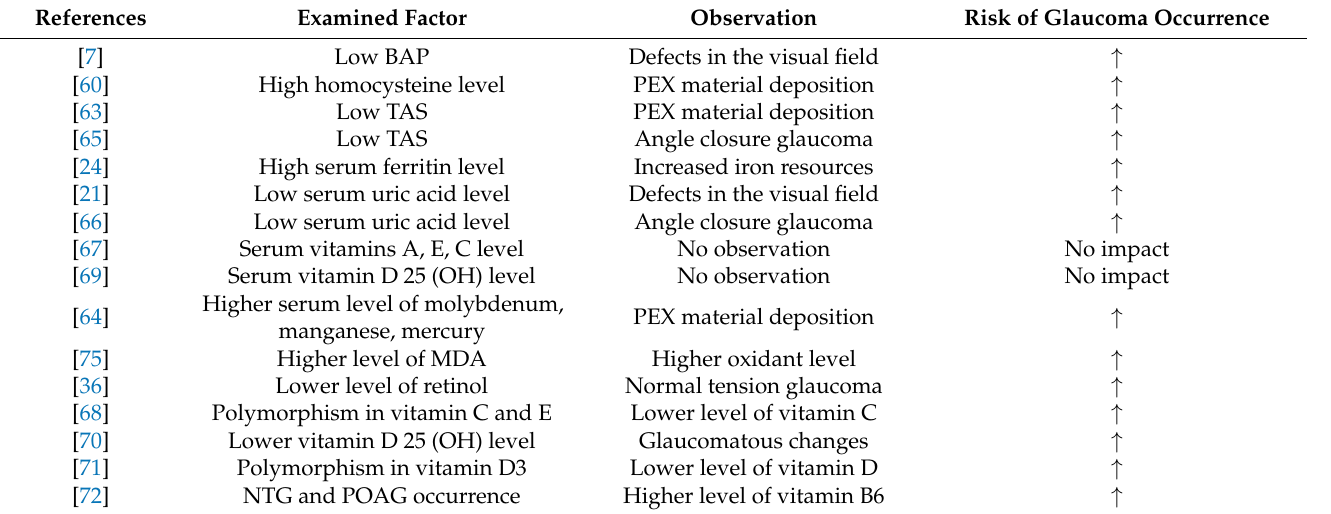
Table 2. Serum elements and oxidative stress in